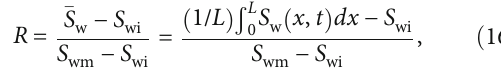
Figure 4: 1D model used for the numerical